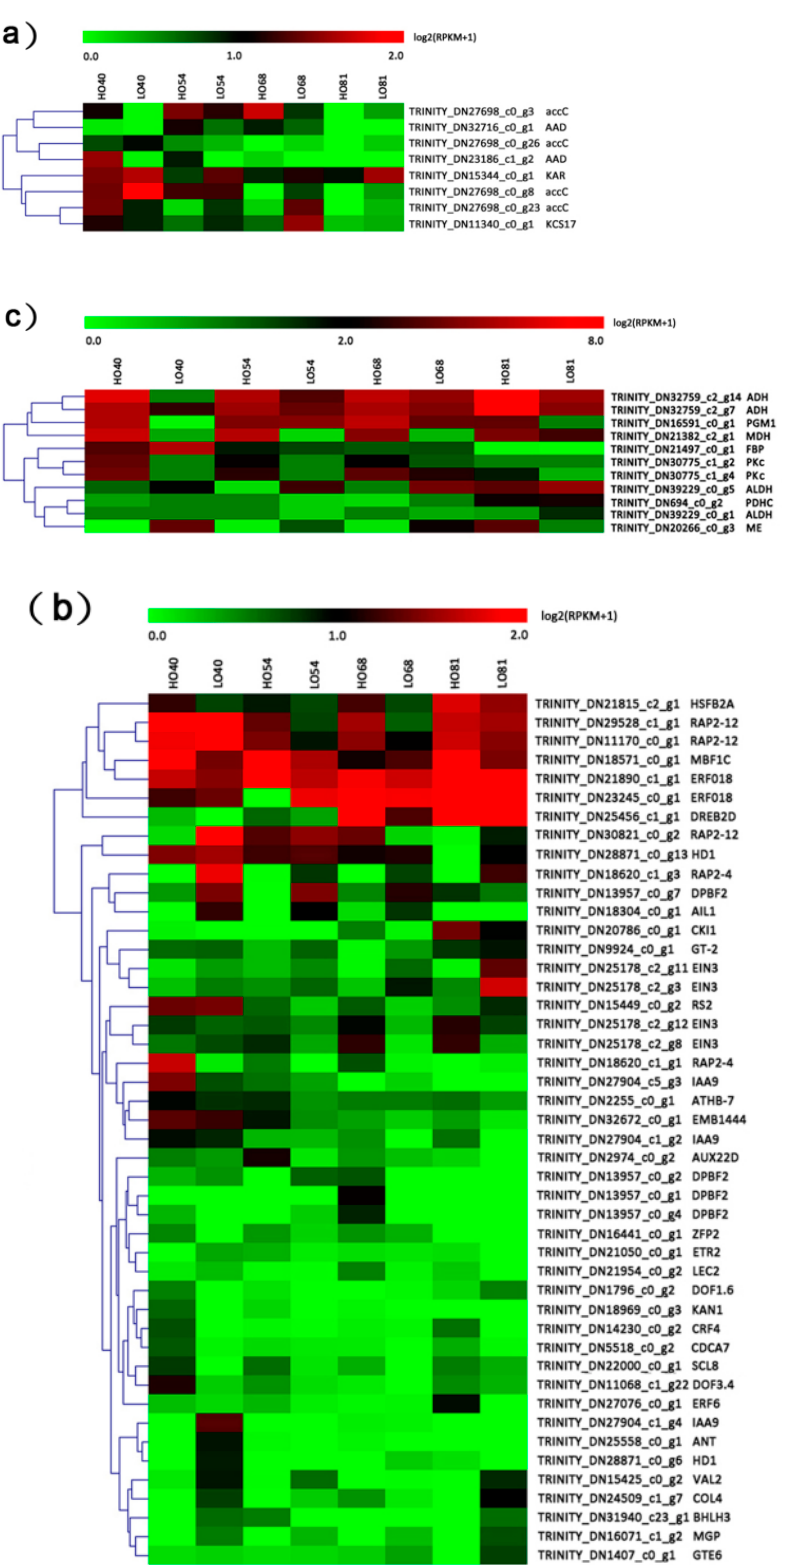
Figure 4. Heatmap diagrams of the expression levels of DEGs between the HO and LO lines at four development stages. ( a ) genes relating to FA biosynthesis; ( b ) transcription factors; ( c ) genes relating to carbon metabolism. Gene expression data were normalized to log2. Red indicates high expression, black indicates intermediate expression, and green indicates low expression.